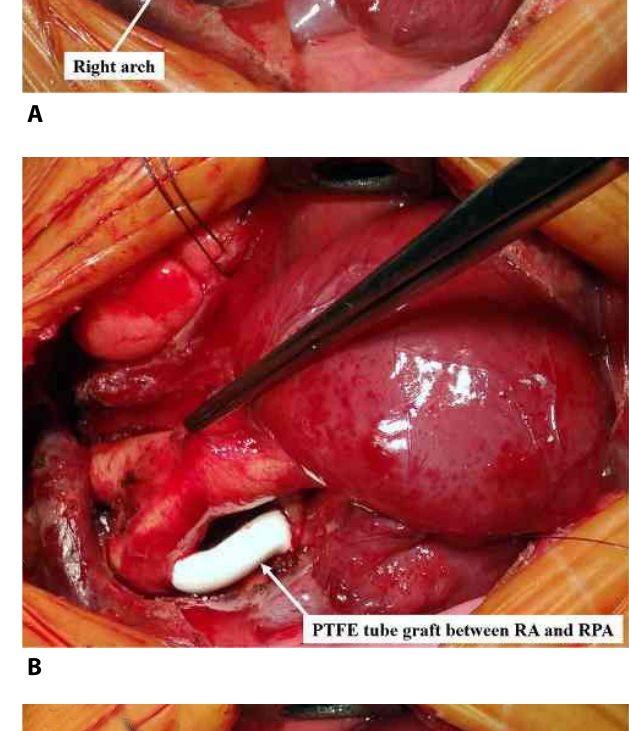
Fig. 2 – (A) Initial aspect of pulmonary atresia with ventricular septal defect and double aortic arch. The left aortic arch is incomplete and continues as patent ductus arteriosus that irrigates both pulmonary branches. The right aortic arch remains as descending aorta. (B) Modified Blalock-Taussig connecting the right aortic arch to the right pulmonary artery with 3.5